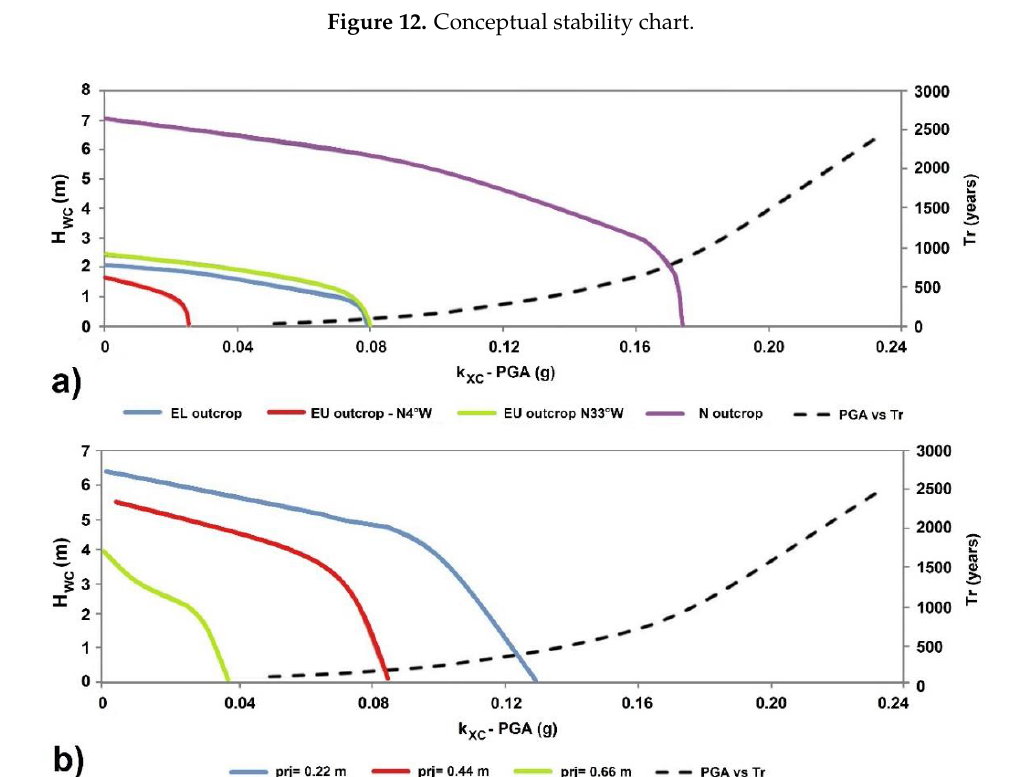
Figure 13. Stability chart, in absence of projection on EL, EU and N sectors ( a ), and in case of projection on the N sector ( b ).